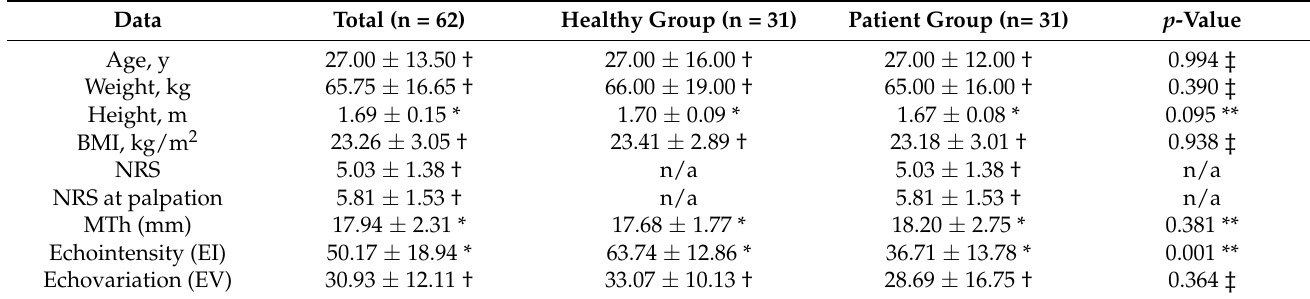
Table 1. Sociodemographic data, pain scores and echotexture variables of the